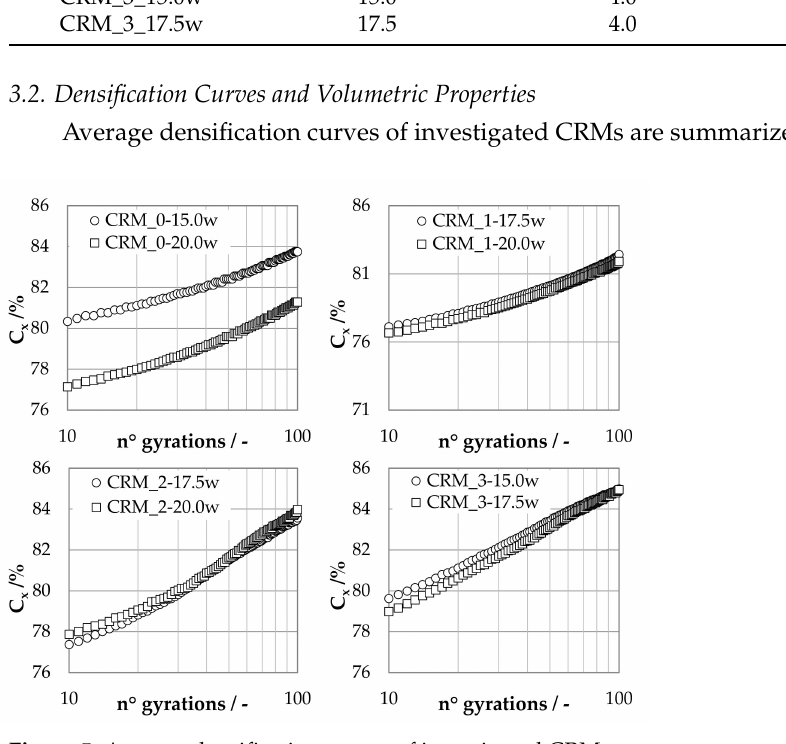
Figure 5. Average densification curves of investigated